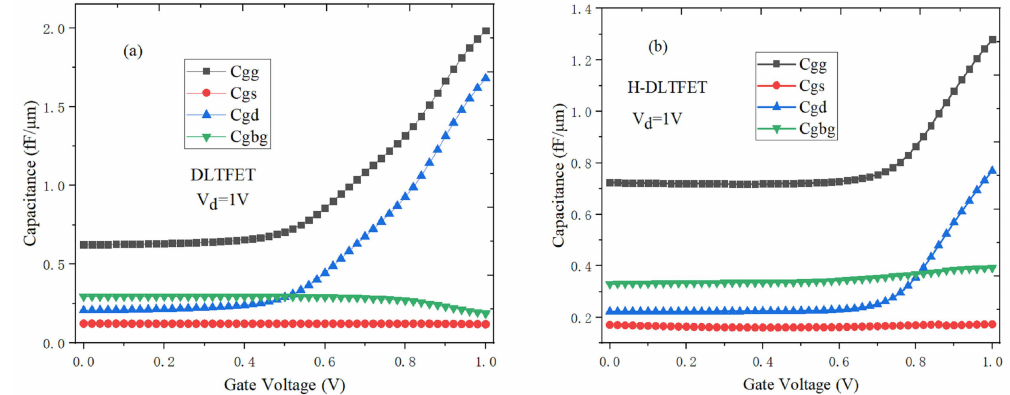
Figure 10. The C-V characteristic of ( a ) DLTFET; ( b )